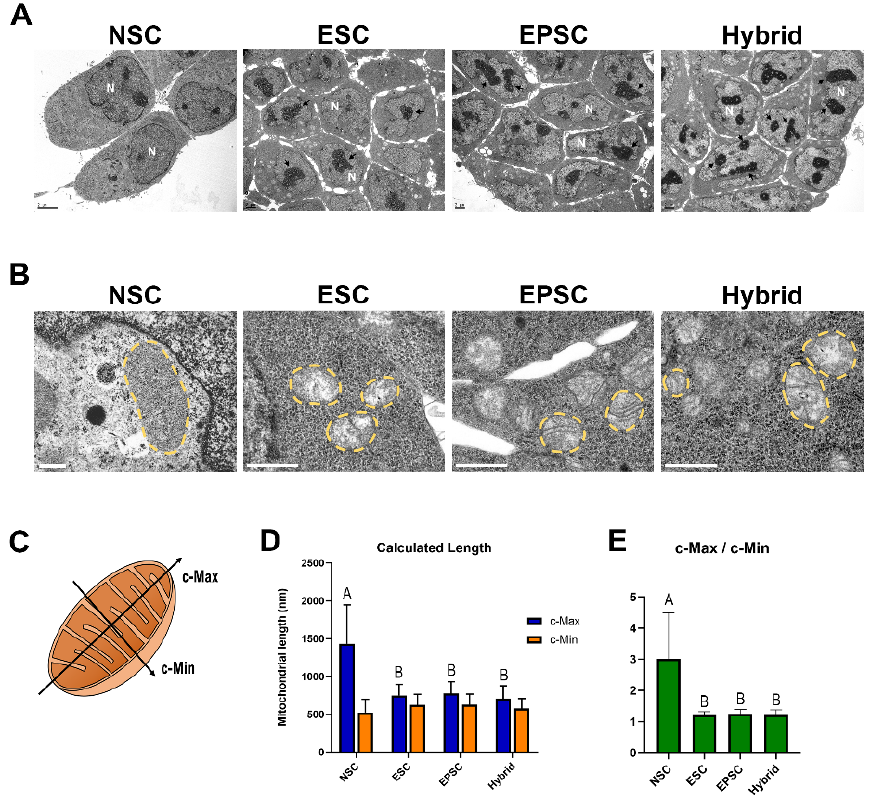
Figure 5. Analysis of mitochondrial morphology among ESCs, NSCs, EPSCs, and EPSC-NSC hybrid cells. ( A ) Representative images of the intracellular ultrastructure of each cell type were observed using transmission electron microscopy (TEM). Black arrows indicate the nucleoli in the nuclei of each cell type. Nuclei (N). Scale bars: 2 µm. ( B ) Representative images of mitochondria of each cell type observed through transmission electron microscopy (TEM). Yellow dotted lines indicate the morphology of mitochondria. Scale bars: 0.4 µm (NSC), 1 µm (ESCs, EPSCs, hybrid cells). ( C ) Illustration of the criteria for the measurement of mitochondrial axes’ length. ( D ) Analyzed mitochondrial length of each axis using the criteria. Data are presented as the mean ± SD for 29 independent mitochondrial samples. A,B Uppercase indicates significant differences among different groups at p < 0.0001. Data were analyzed using one-way ANOVA and Dunn’s post hoc with SAS ® software, version 9.4, (Institute of INC, Cary, NC, USA). ( E ) The ratio of the c-Max and c-Min axes of mitochondria. Data are presented as the mean ± SD for 29 independent mitochondrial samples. A,B Uppercase indicates significant differences among different groups at p < 0.0001. Data were analyzed using one-way ANOVA and Dunn’s post hoc with SAS ® software, version 9.4, (Institute of INC, Cary, NC,